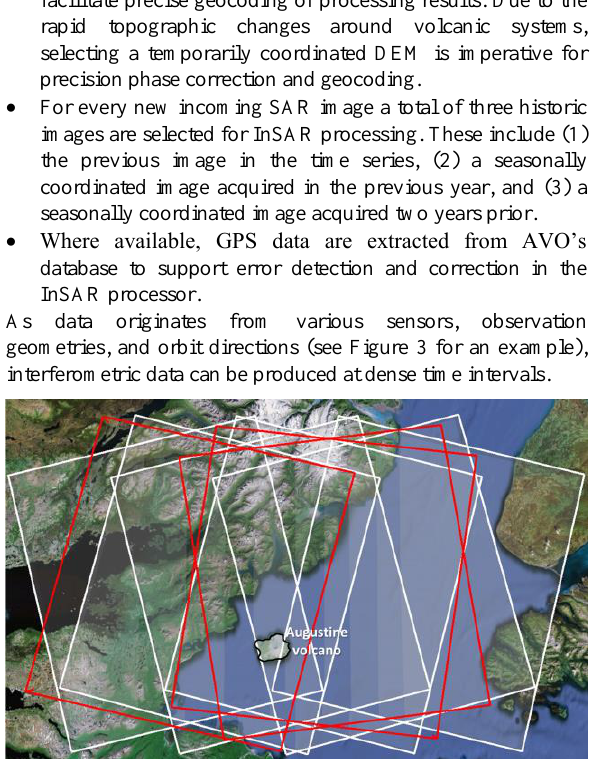
covering Augustine volcano, Alaska. White frames are ERS-2 data and red frames identify Radarsat-1